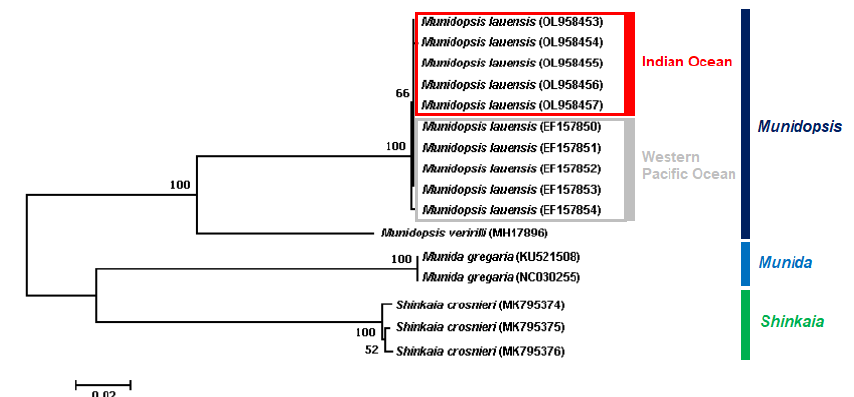
Figure 3. Genetic relationships between Munidopsis lauensis isolates from the Indian and western Pacific Oceans based on mitochondrial cytochrome oxidase subunit 1 (COI) sequences. Munida gregaria and Shinkaia crosnieri were used as outgroups.